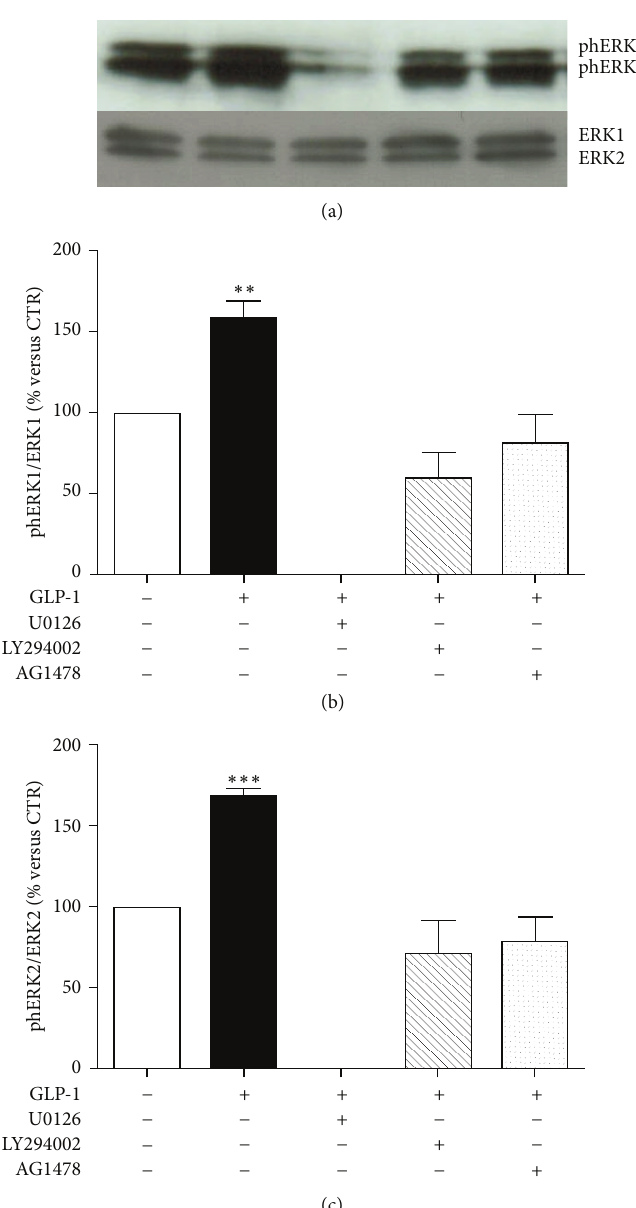
Figure 6: Pharmacological inhibition of PI3K blocked GLP-1-induced activation of ERK1/2. ARPE-19 cells were cultured in serum-free medium for 24 hours and stimulated for 10 minutes with 10 nmol/L GLP-1 in the presence or absence of MEK1/2 inhibitor U0126 (10 𝜇 mol/l) or PI3K inhibitor LY294002 (50 𝜇 mol/l), or EGFR inhibitor AG 1478 (0.25 𝜇 mol/l). (a) Representative western blot analysis of ERK 1/2 phosphorylation (phERK1/2) and total protein is shown. (b) Quantification of densitometries of western blot bands of phERK1. Data were expressed as mean ± SE of fold induction relative to total ERK1 ( 𝑛 = 3 ). ∗∗ 𝑃 < 0.01 versus cells stimulated with control medium alone. (c) Quantification of densitometries of western blot bands of phERK2. Data were expressed as mean ± SE of fold induction relative to total